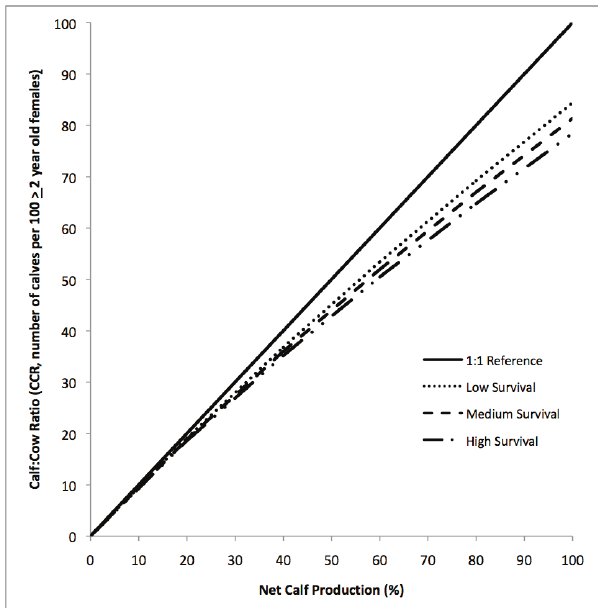
Fig. 1. Calf:cow ratios (CCR; i.e. , where the denomina- tor includes sexually-immature 2-year-olds) in relation to net calf production (NCP; i.e. , where the denominator includes only ≥ 3-year-old sexually-mature females) at low (60, 70%), medium (70, 80%), and high (80, 90%) levels of overwinter calf and annual yearling survival, respec- tively (see Table 1).